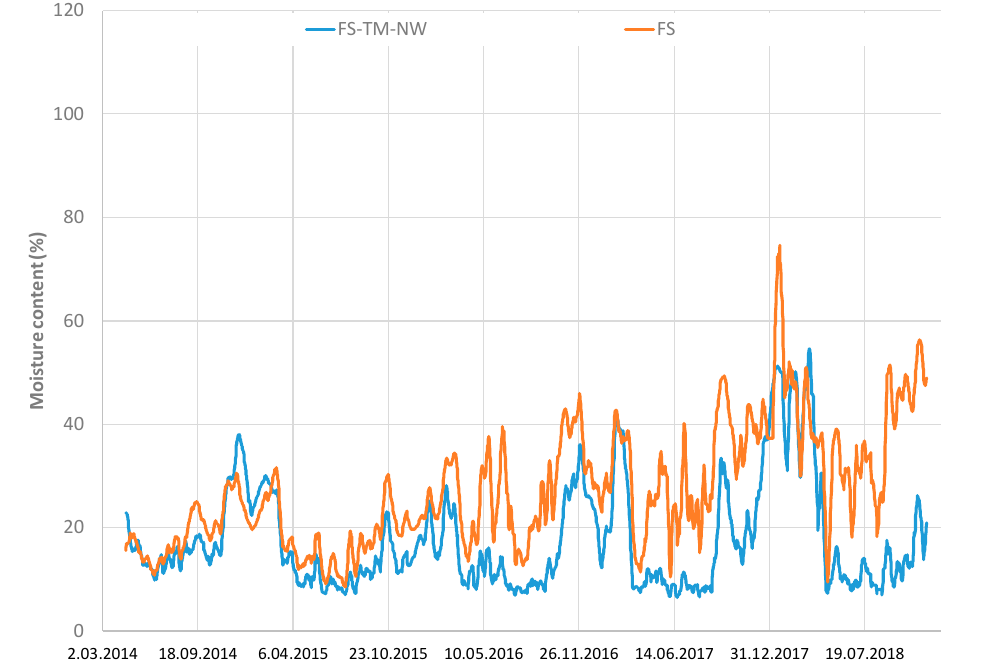
Figure 3. MC of spruce (PA), thermally modified spruce (PA–TM), wax-treated spruce (PA–NW) and wax-treated thermally modified spruce (PA–TM–NW) decking of model house in Ljubljana in the period between 11 April 2014 and 26 November 2018. Plots displayed are moving averages of 20 measurements.